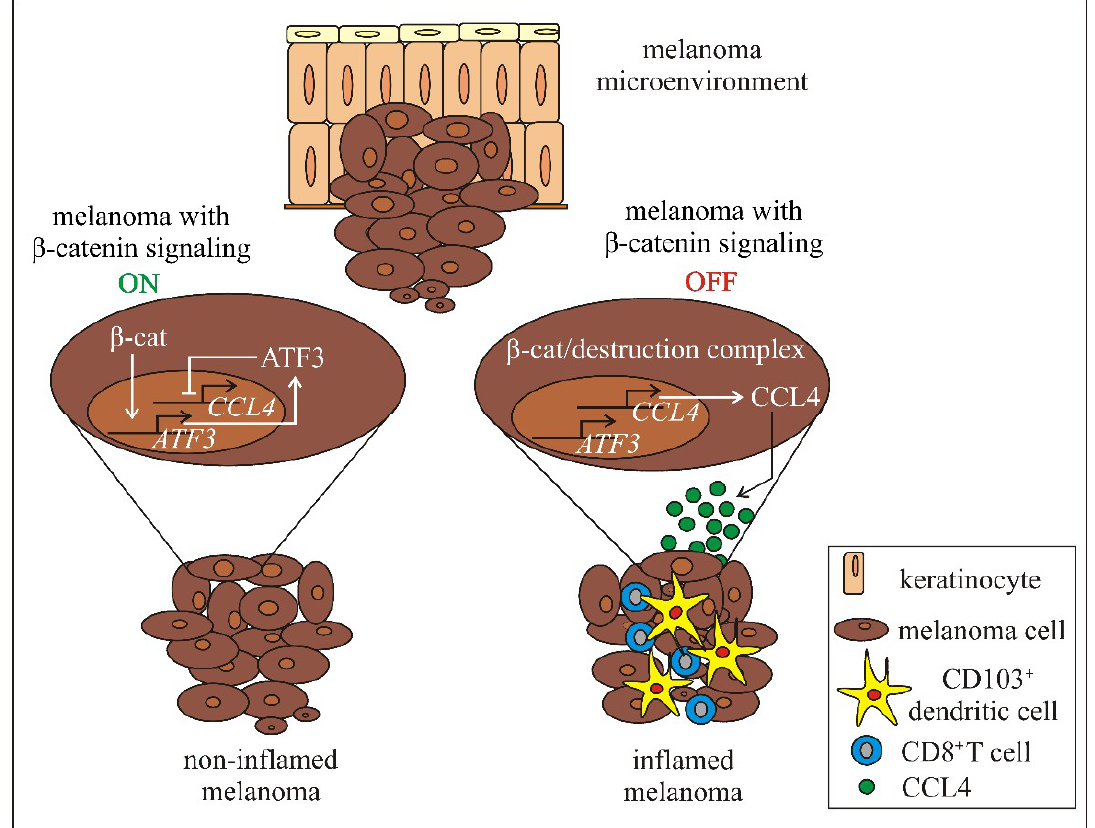
Figure 5. Mechanisms of immune exclusion in melanoma through WNT/β-catenin-signaling [172]. β-catenin induces expression of ATF3 and ATF3 represses transcription of CCL4 . CD103 + dendritic cells and cytotoxic CD8 + T-cells are not recruited to melanoma, which leads to non-inflamed tumor. When β-catenin-signaling is inactive in melanoma cells, ATF3 is not expressed, which restores CCL4 production and secretion. This stimulates recruitment of immune cells, including CD103 + dendritic cells that activate CD8 + T cells. Recruitment of tumor specific CD8 + T cells in the tumor microenvironment results in immune inflamed melanoma. ATF3— activating transcription factor 3; β- cat— β- catenin; CCL4— CC-motif chemokine ligand 4.